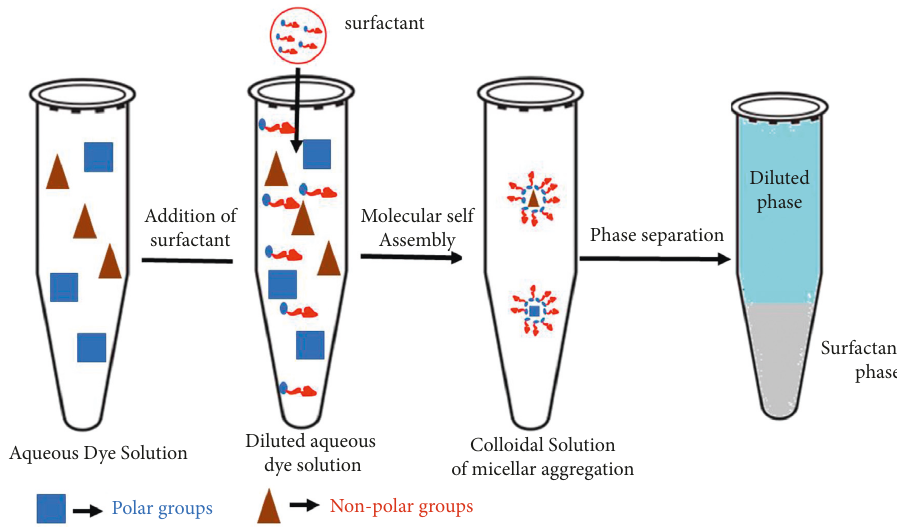
Figure 1: Structure of Reactive Black-5